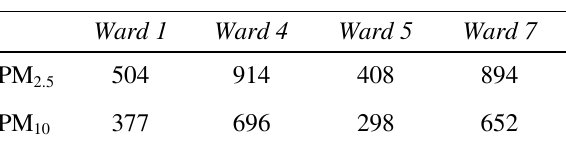
Table 2: Comparisons of Estimated Excess Cases for Pediatric Asthma ERV for Summer IOP Summer IOP